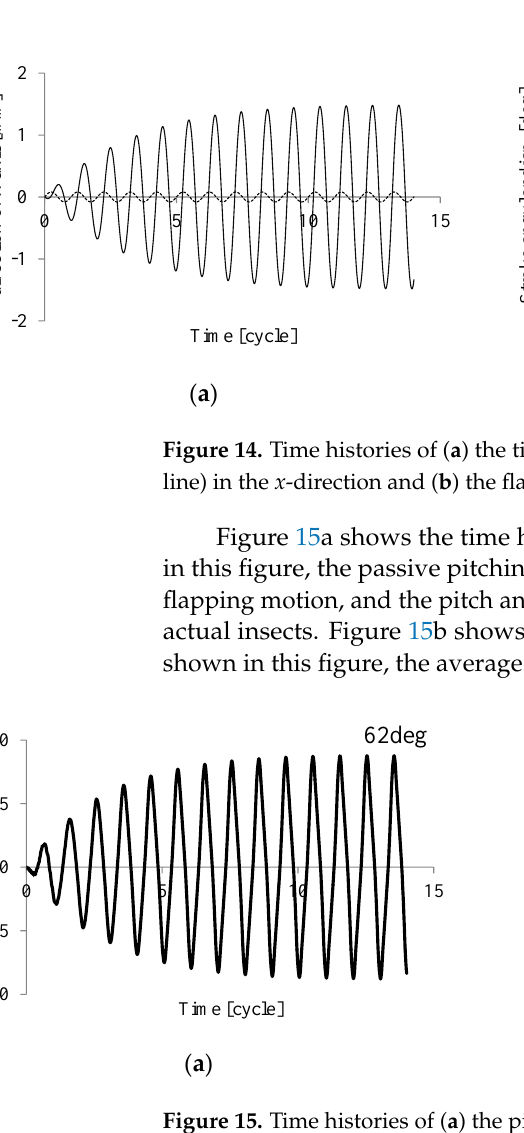
Figure 13. Geometry of the fluid domain and the employed meshes: ( a ) The geometry of the fluid domain; ( b ) The yz - plane view of the wing’s mesh, where the domain colored by yellow is the plate spring; ( c ) The yz -plane view of the fluid domain; ( d ) The xy -plane view of the fluid domain.